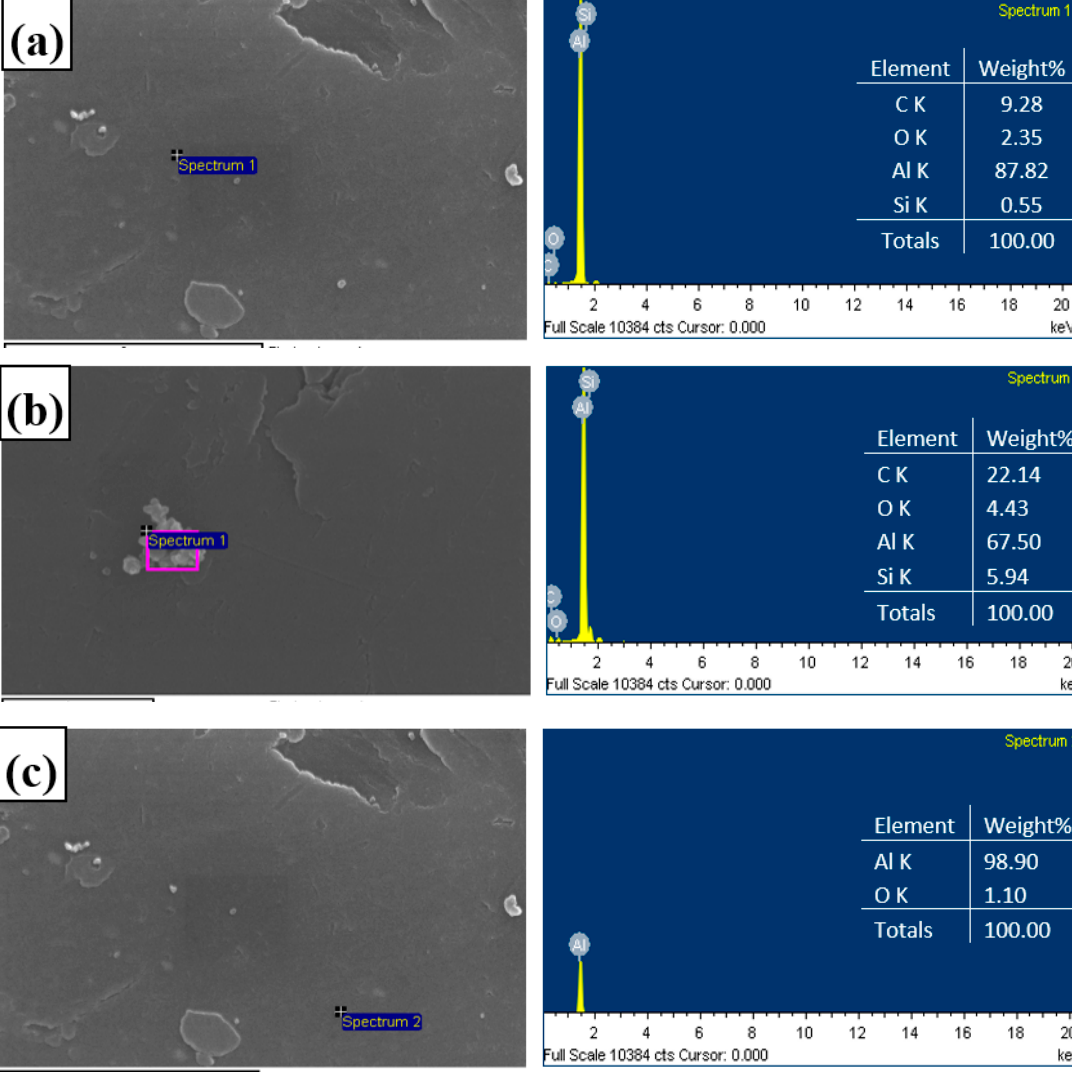
Figure 3. EDS analysis for the powder composite: ( a ) point spot on SiC single particle, ( b ) area spot on SiC agglomerated particles, and ( c ) point spot on Al base matrix.